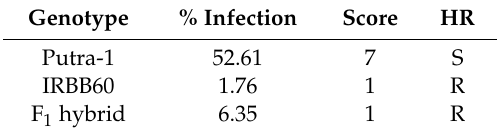
Table 4. Reaction of Putra-1 and IRBB60 parental varieties including the F 1 progenies to Xoo isolate.